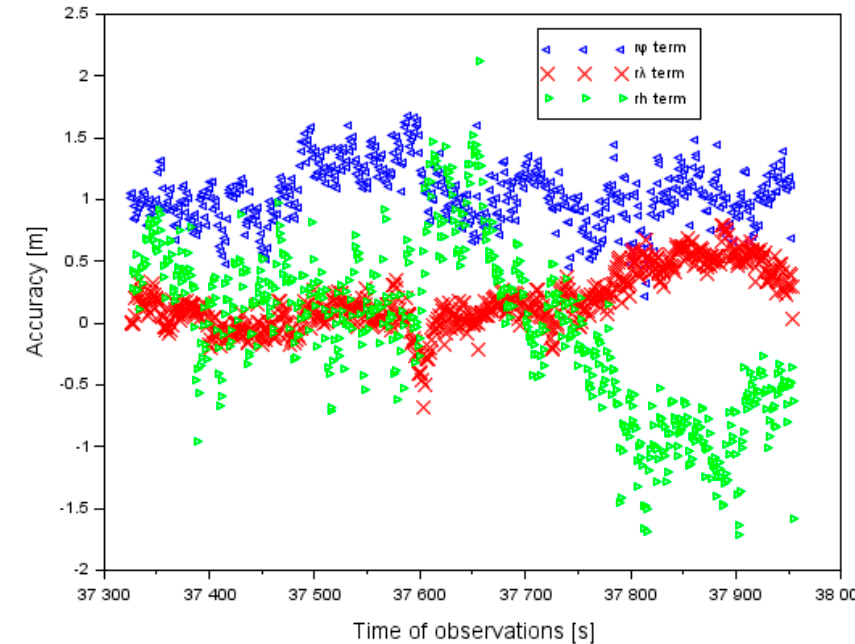
Figure 4. Accuracy of aircraft positioning in the ellipsoidal coordinates in the air test in D ę blin.